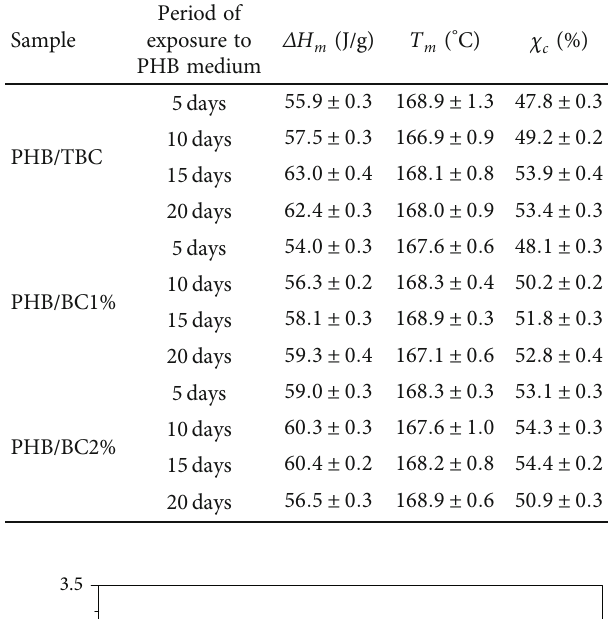
Table 4: Thermal properties of PHB/TBC and PHB/BC composite materials after in vitro degradation.